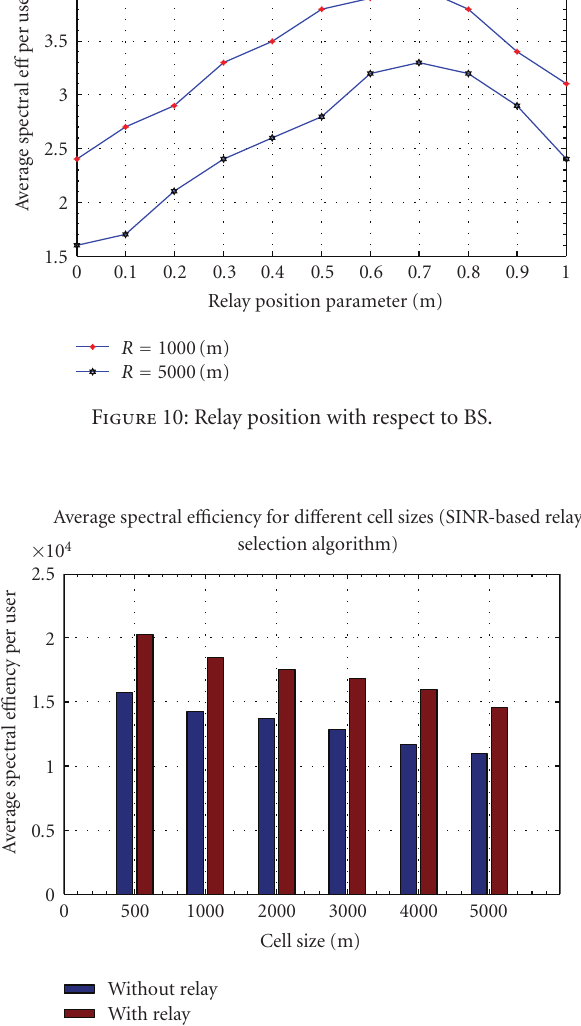
Figure 11: Average spectral e ffi ciency for di ff erent cell size (central cell).